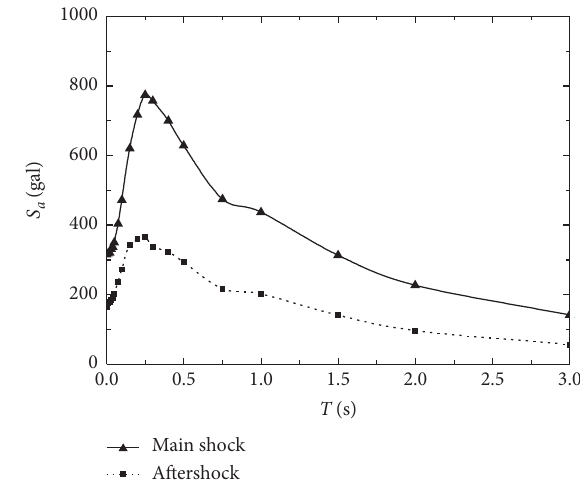
Figure 3: Acceleration response